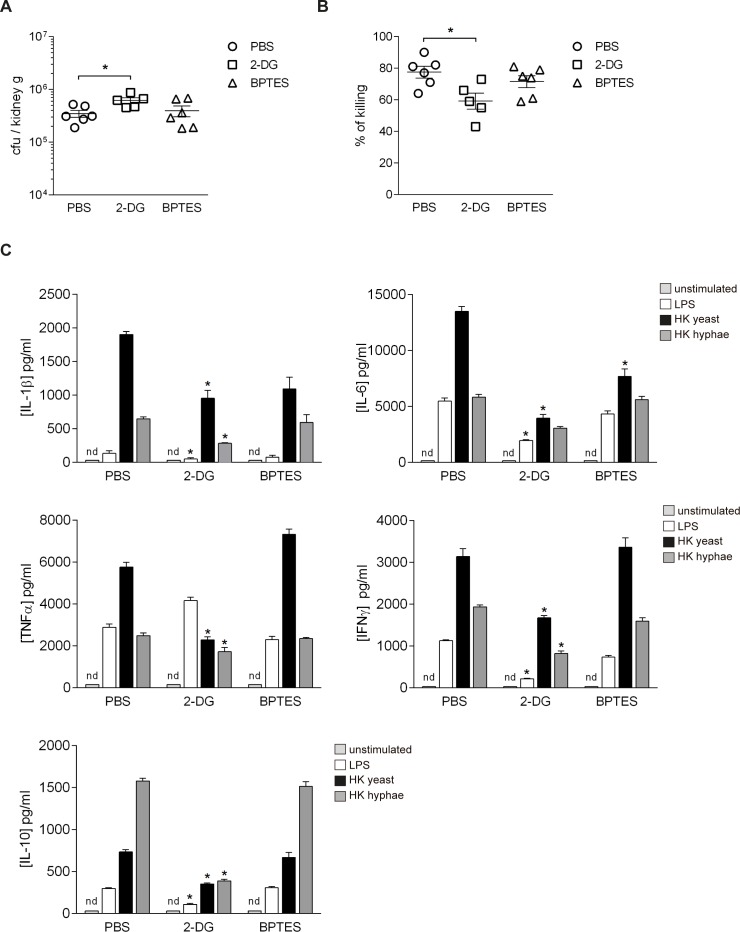
Inhibition of glucose metabolism impaired in vivo responses to systemic C. albicans infection.(A) Fungal burden measured in the kidneys of C57BL/6 mice treated with PBS, 2-DG or BPTES during 5 days after i.v. C. albicans challenge (mean ± SEM, n = 6; similar results were obtained in 2 independent experiments). *p<0.05, Student’s t test. Each dot represents one mouse. (B) Candidacidal activity of neutrophils isolated from blood of C57BL/6 mice treated with PBS, 2-DG or BPTES during 5 days after i.v. C. albicans challenge (mean ± SEM, n = 6; similar results were obtained in 2 independent experiments) *p < 0.05, Student’s t test. Each dot represents one mouse. (C) IL-1β, IL-6, IL-10, IFNγ and TNFα production by mouse splenocytes obtained from PBS, 2-DG or BPTES-treated mice 5 days after C. albicans i.v. infection were measured by ELISA 48 h after in vitro restimulation with medium, LPS, heat-killed C. albicans yeast or heat-killed C. albicans hyphae (mean ± SEM, n = 6; similar results were obtained in 2 independent experiments) *p<0.05, Student’s t test.